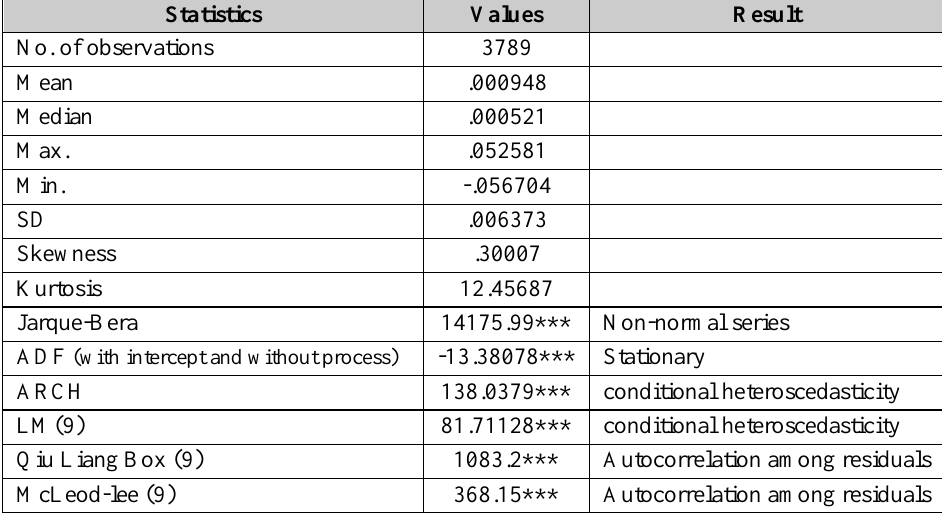
Table 1: Results of Descriptive Statistics for Rate of Return (Rt) Statistics